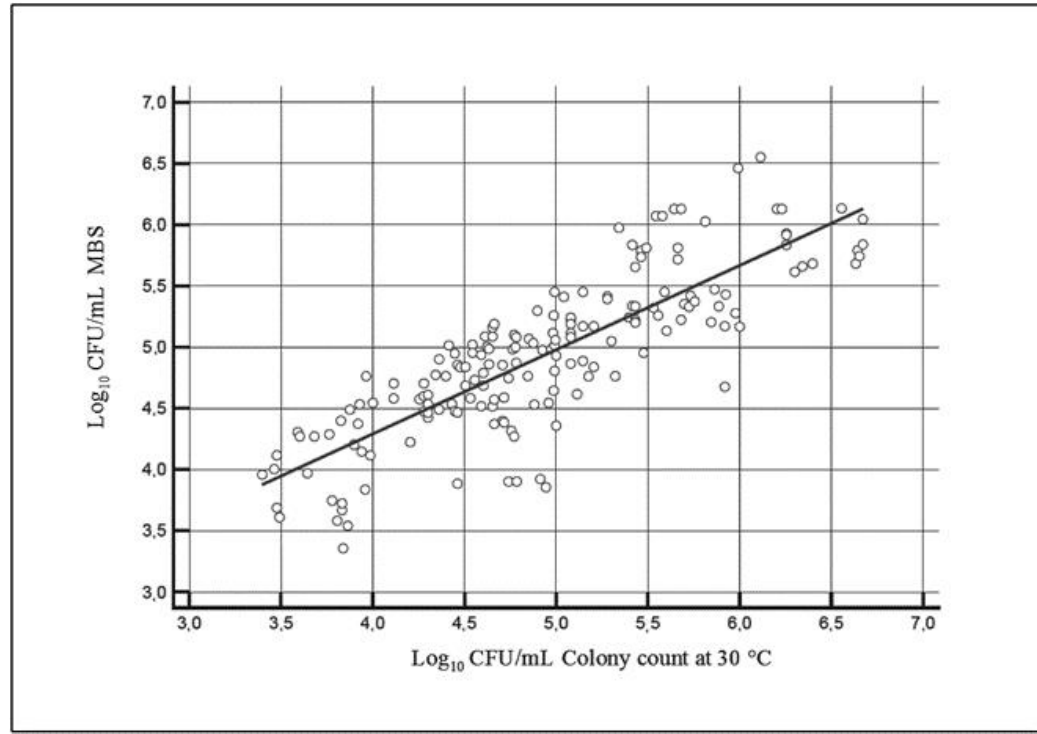
Figure 4. Relation between the results (log CFU/mL) of the alternative MBS method and the reference method for total bacterial count at 30 °C in bovine raw milk. Table 2. Confidence interval (CI) results for the 6 categories identified in the study. Group Range (log 10 CFU /